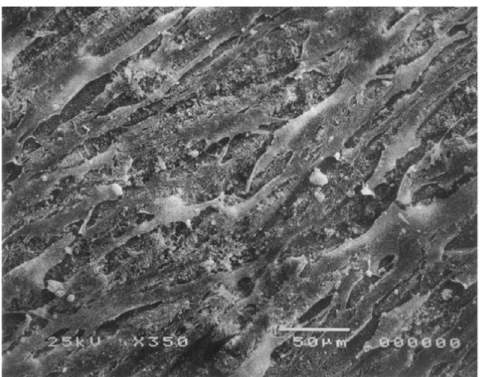
Figure 1: Cell morphology of bone marrow formed along grooves and in fl uenced by surface roughness ( reproduced from ref. [ 27 ])